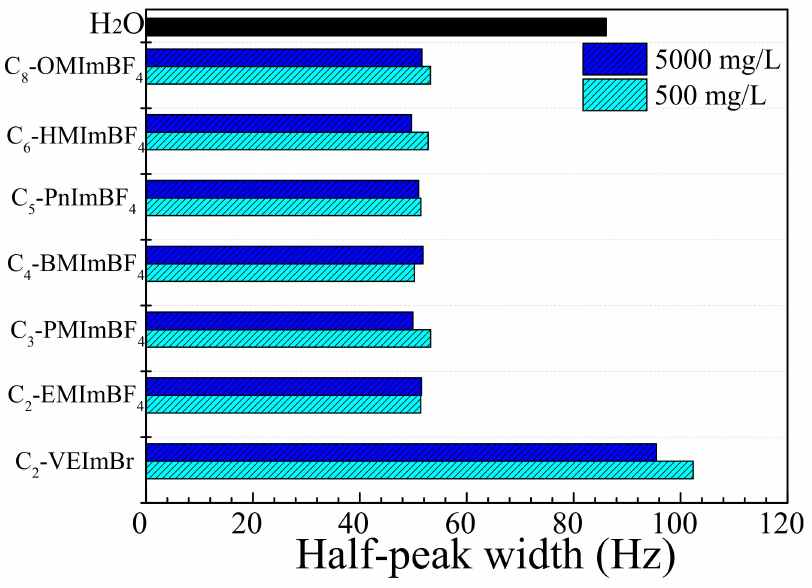
Figure 3. Half-peak width of the 17 O NMR spectra of H 2 O and ILs at different